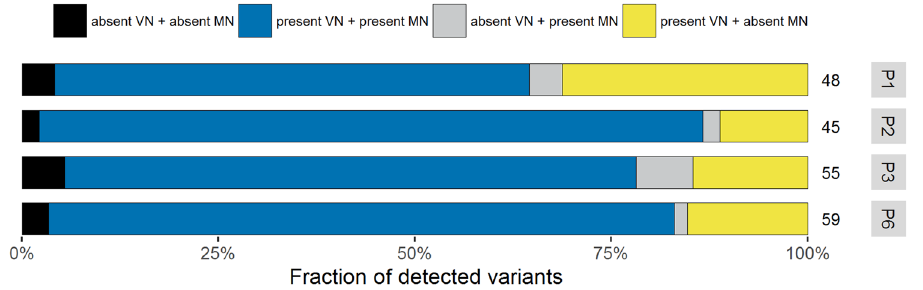
Figure 2. Defining somatic origin of variants using matched normal DNA (MN) or virtual normal genomes (VN) as reference. Annotation of variants detected in the primary tumors of the four patients of who matched normal was accessible (P1, P2, P3 and P6) are depicted relative to the total variants in that sample. In here, variants absent from both the VN and MN in black, variants present in both VN and MN in blue, variants absent in the VN but present in the MN in grey, and variants present in the VN but absent from the MN in yellow. The total number of detected variants is depicted at the right end of the bars.